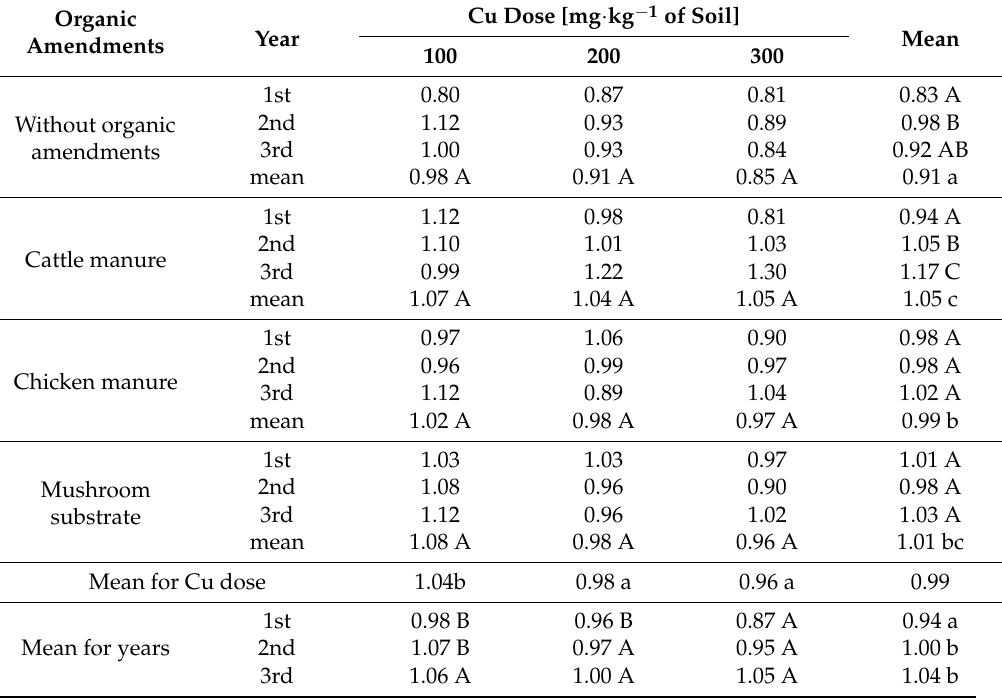
Table 6. Cocksfoot tolerance index to copper depending on Cu doses (Cu/Org), calculated according to equation number